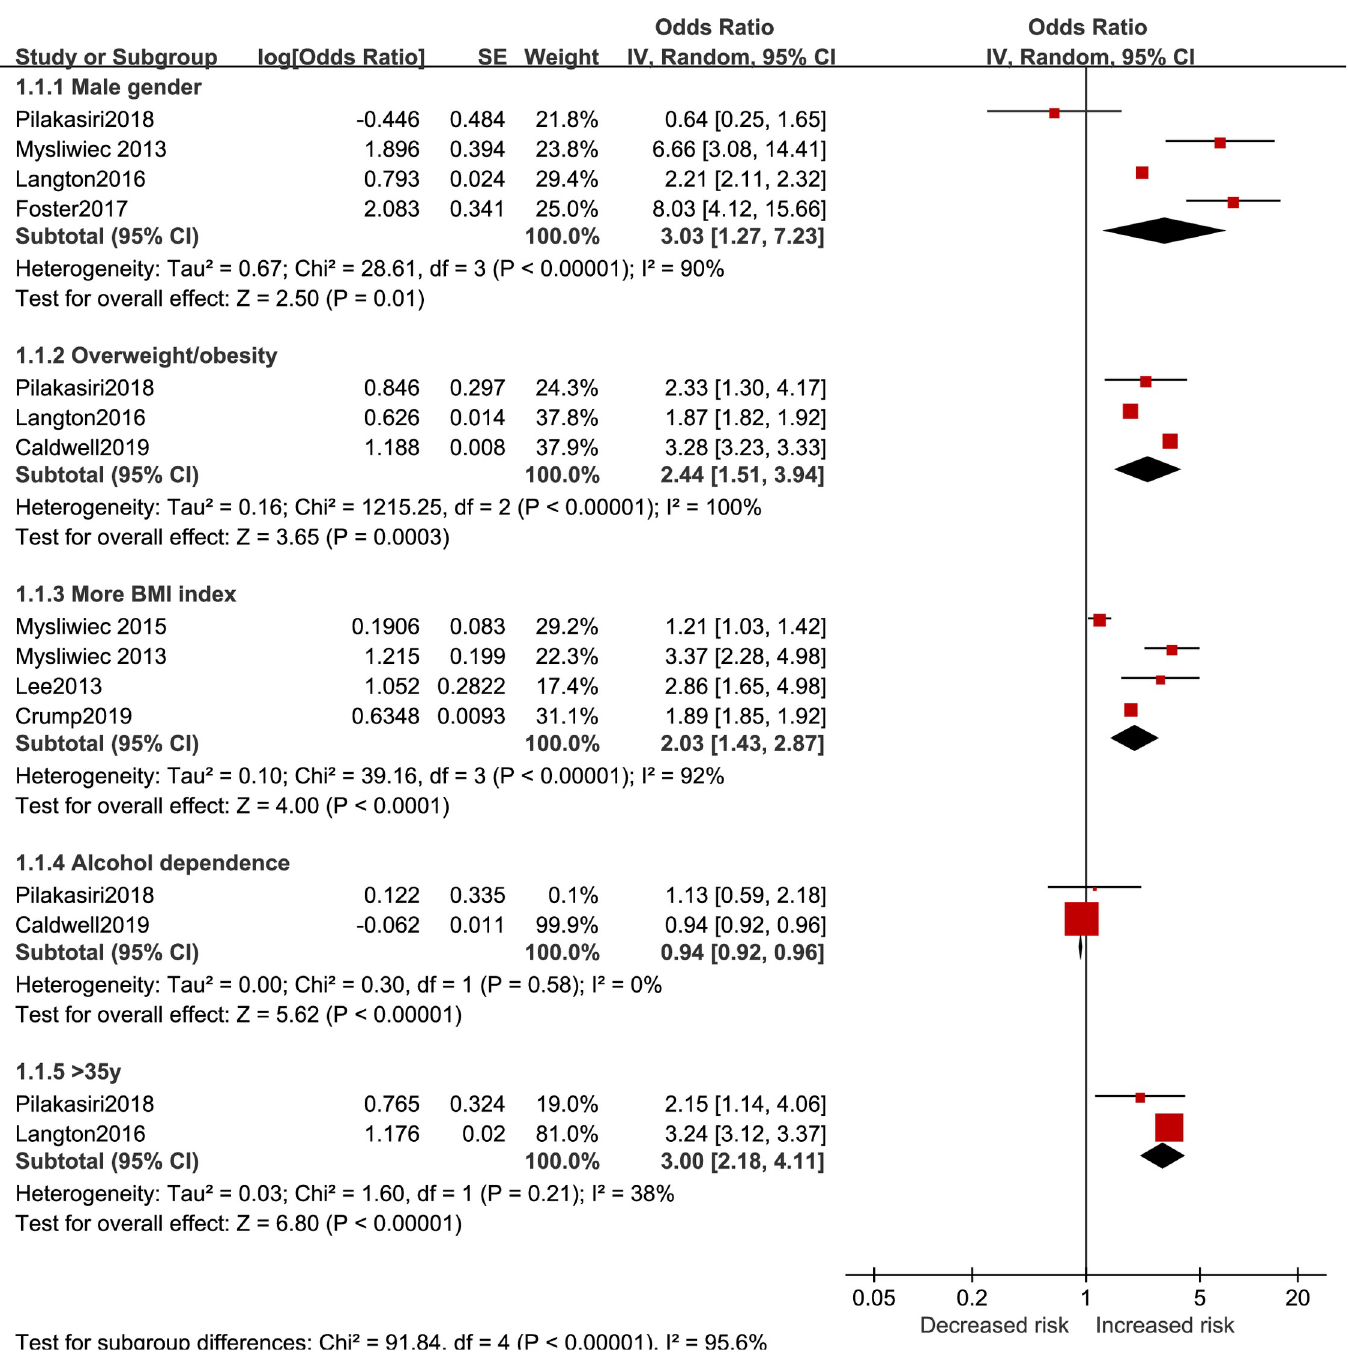
(OR = 1.92, 95%CI 1.38 to 2.67) led to higher insomnia risk. The total effect of army-specific factors showed a significant increase of insomnia risk (OR = 1.71, 95%CI 1.39 to 2.10). Comorbidity factors. Results of comorbidity effect for insomnia risk are reported in Fig 7. One included article in the PTSD category was identified as an outlier and excluded during